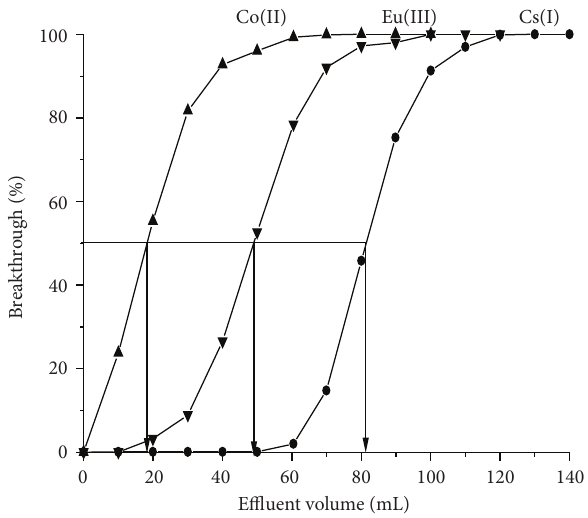
F 2: Breakthrough curves of Cs(I), Eu(III) and Co(II) from 1g zirconium selenomolybdate column (0.6cm i.d.) matrix using individual feeding solution of 1